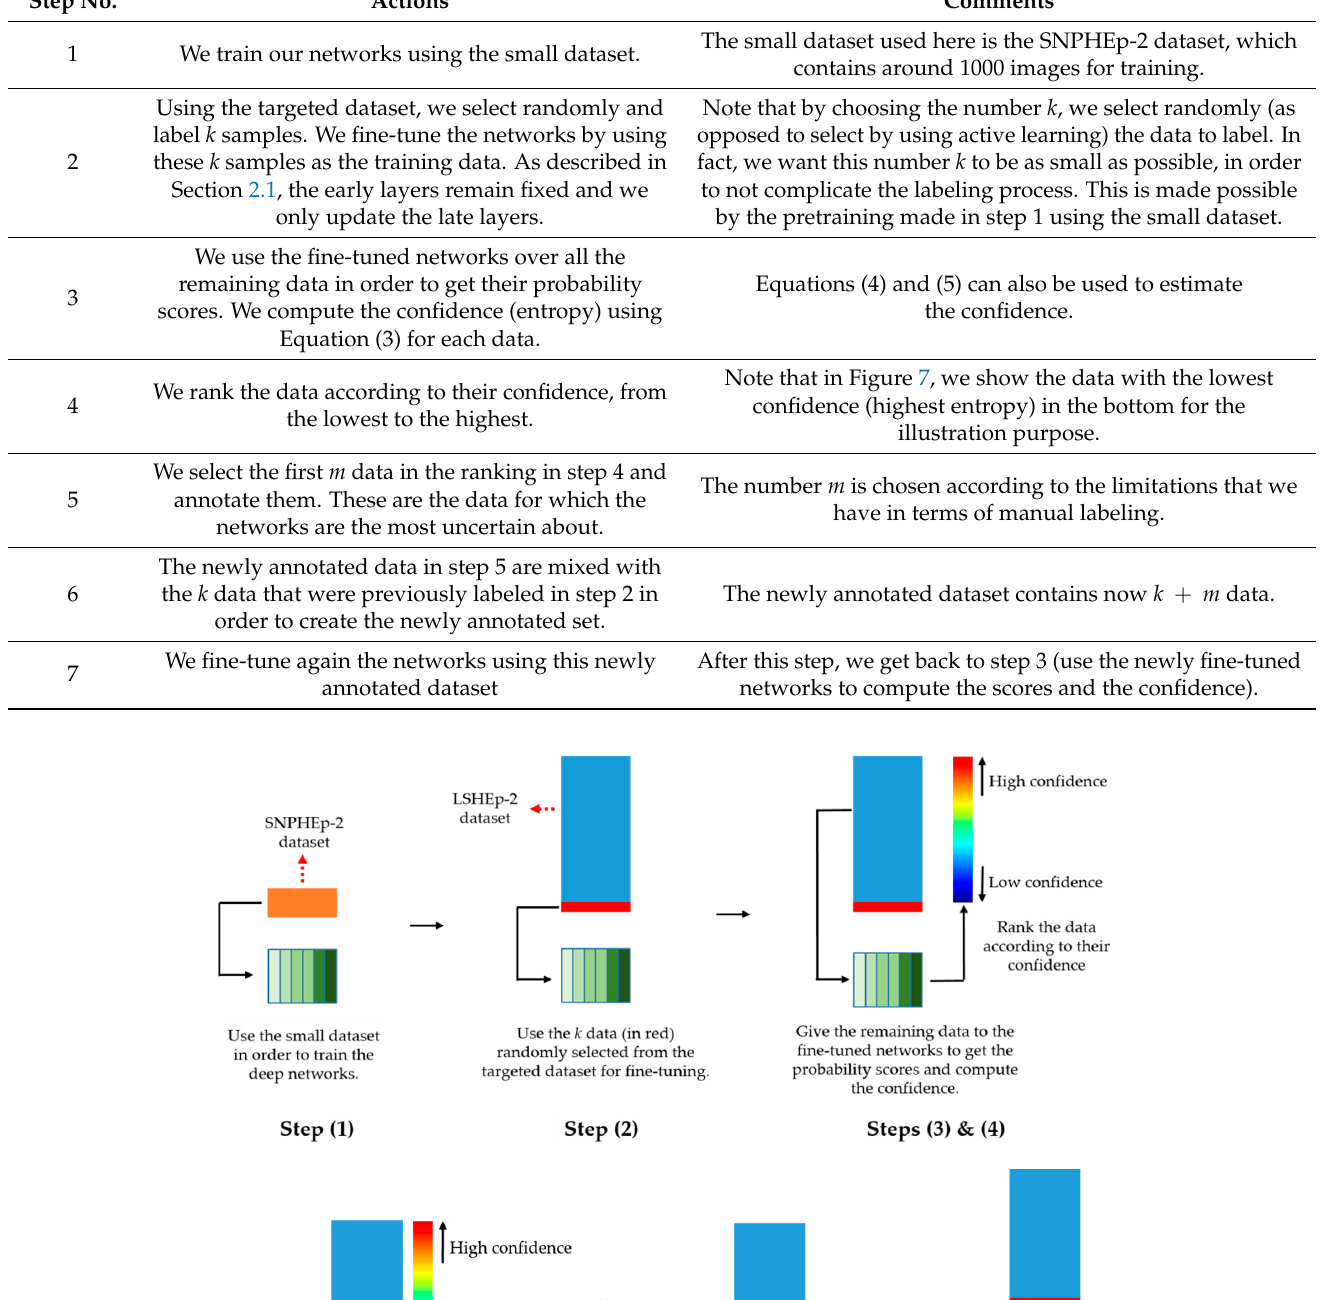
Figure 7. Illustration of the different steps of the proposed active learning scheme. LSHEp-2 stands for the large-scale HEp-2 dataset.